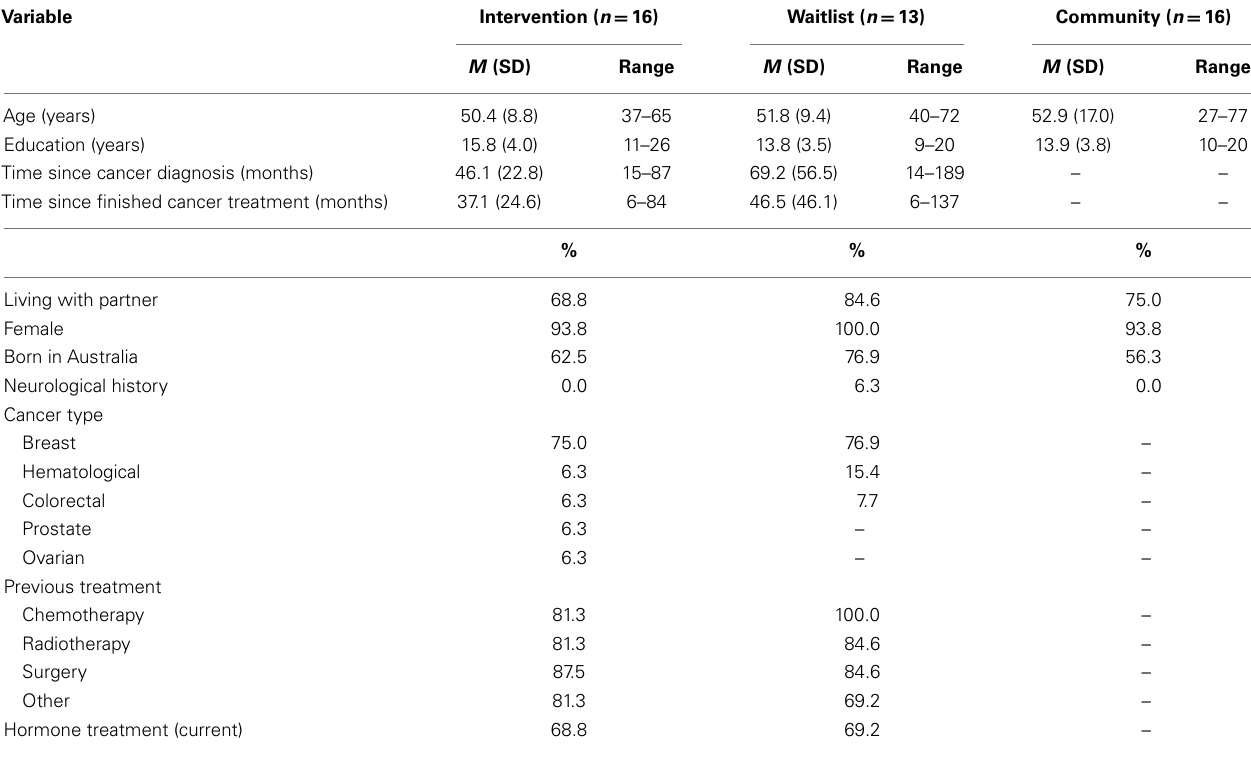
Table 2 | Participant characteristics